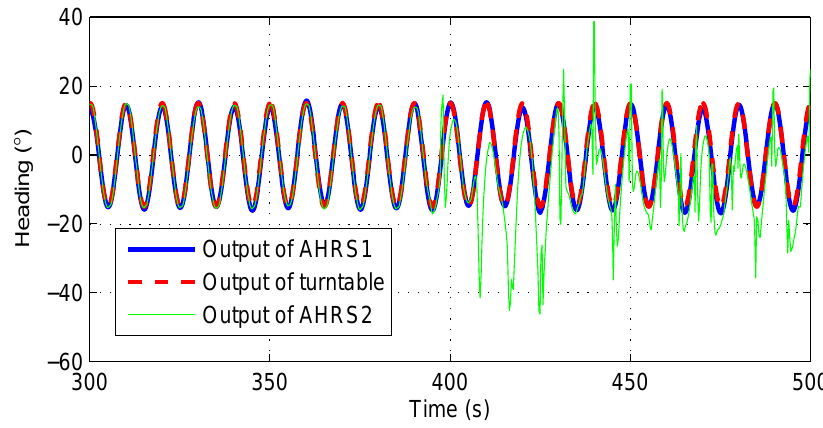
Figure 14. Heading comparison between AHRS1, AHRS2, and the turntable. Magnetic interference is added after 400 s.